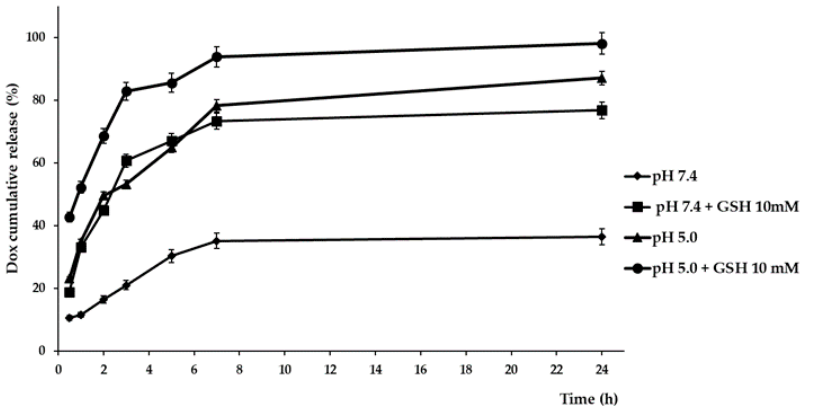
Figure 7. DOX release profiles from DOX@DFNPs in different pH and redox conditions.